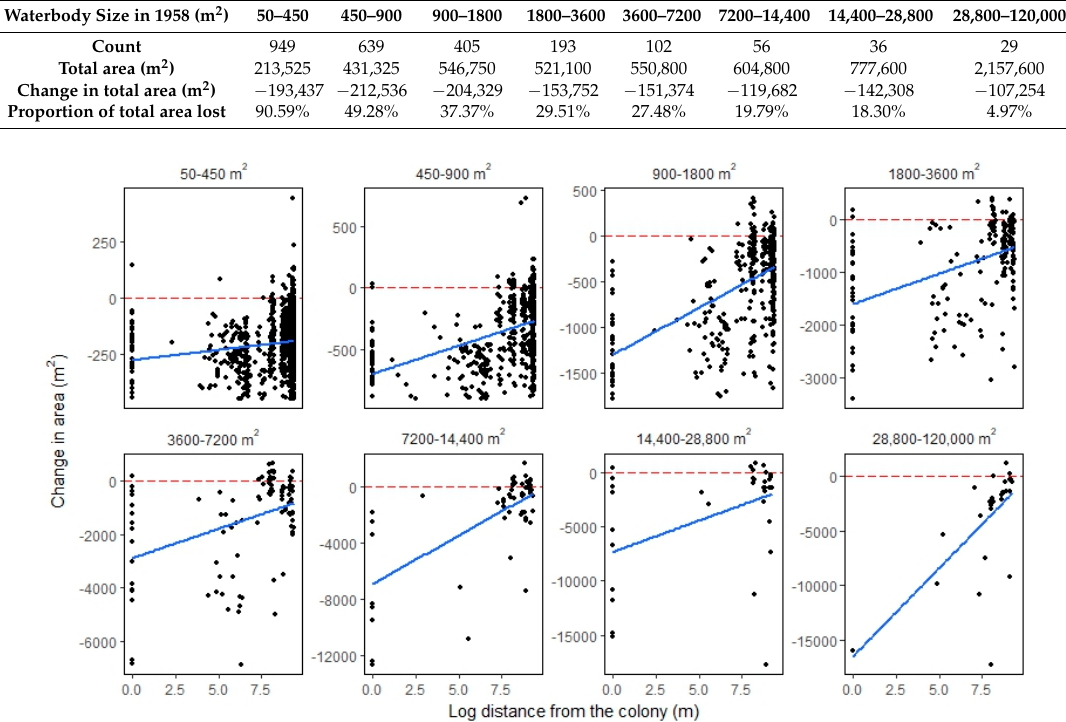
Figure 5. Visualization of the interaction effect (distance from the colony and waterbody size) in the best model (Table 4). Data were divided based on the waterbody size classes indicated above each panel. Each point represents the change in area of a single waterbody. The blue lines show model predictions for waterbody area change within that size class. The dotted red reference lines show no change in waterbody area. Table 4. Candidate models for change in waterbody area, with goodness-of-fit metrics. The table is ordered by the model fit, and the best model is shown in bold.